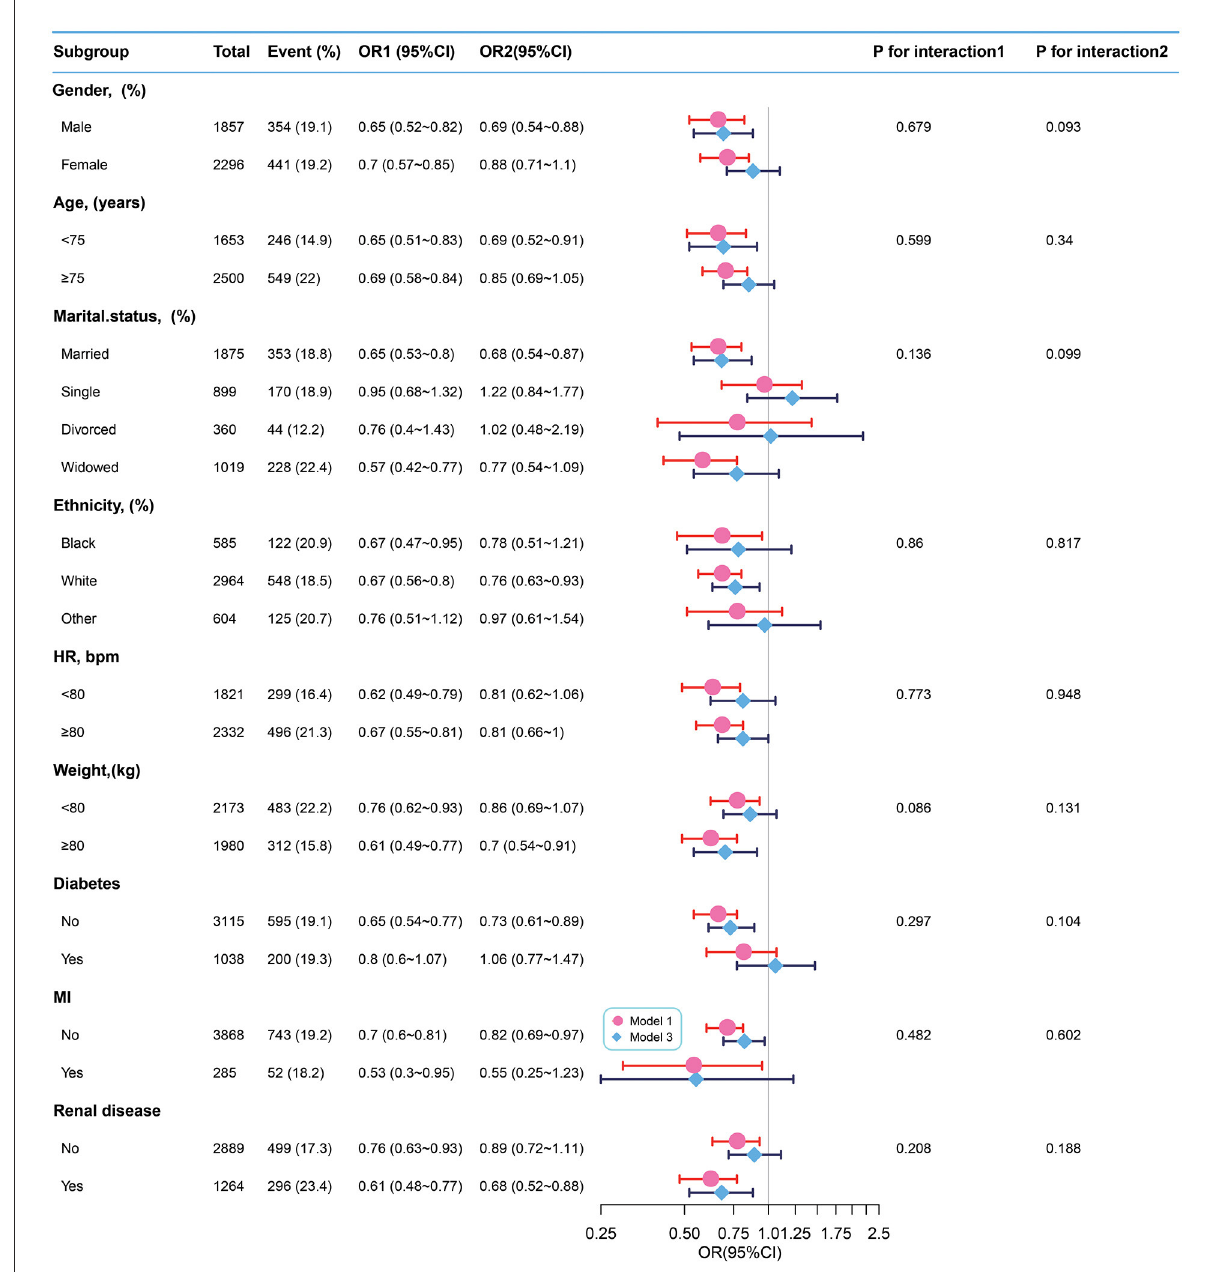
FIGURE4 Subgroup analyses of BT and in-hospital mortality. Adjustment factors included gender, age, marital status, ethnicity, weight, WBC, albumin, BUN, INR, PTT, anion gap, bicarbonate, calcium, chloride, sodium, HR, SBP, DBP, MBP, RR, SpO2, the presence of renal disease, the presence of severe liver disease, the presence of malignant cancer, the presence of myocardial infarction, the presence of cerebrovascular disease, the presence of peripheral vascular disease, the presence of diabetes, the presence of chronic pulmonary disease, and CCI. BT, body temperature; HR, heart rate; MI, myocardial